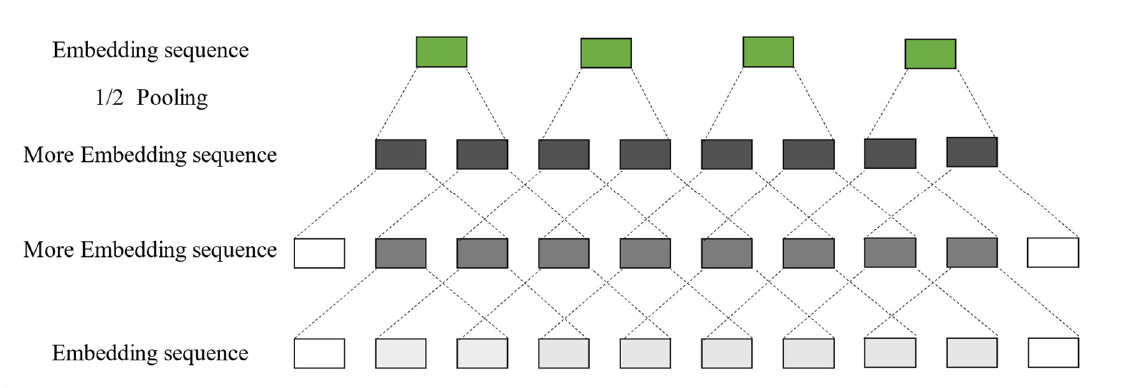
Figure 2. BTCDC Convolution Pooling Layer.